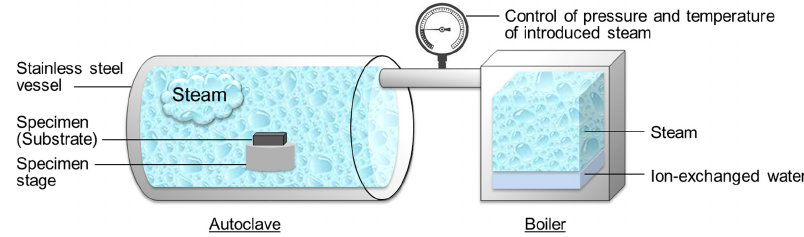
Figure 1. Schematic of proposed steam coating technique.